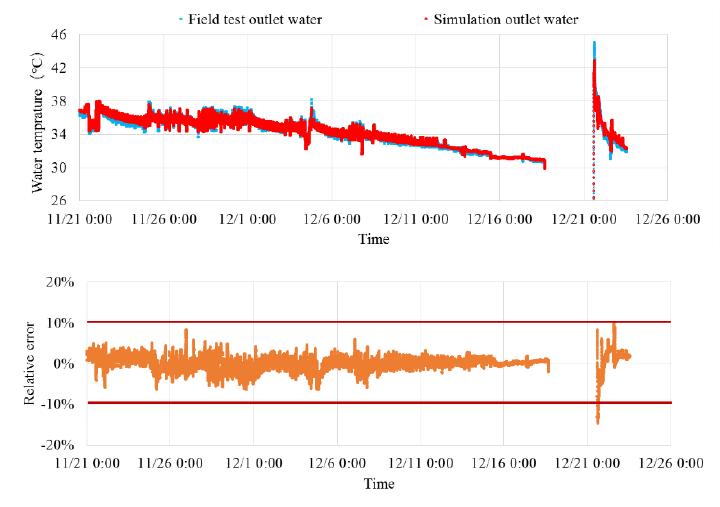
Figure 8. Comparison of field test values and simulation